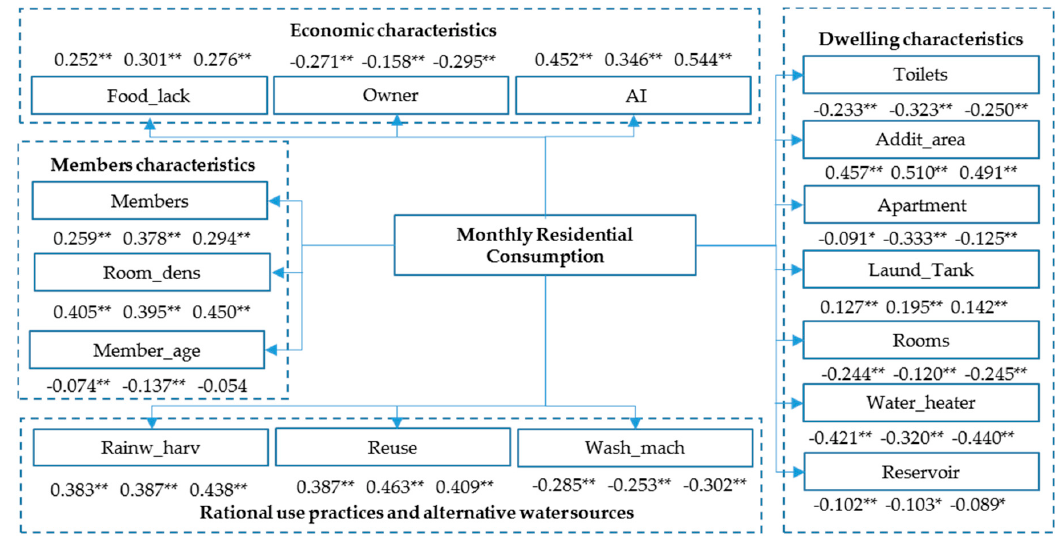
Figure 4. Spearman coefficients of variables most correlated with consumption. Note: for example, the variable Food_lack in scenario ( a ) ρ = 0.252, scenario ( b ) ρ = 0.301, scenario ( c ) ρ = 0.276. * p < 0.05, ** p < 0.01.